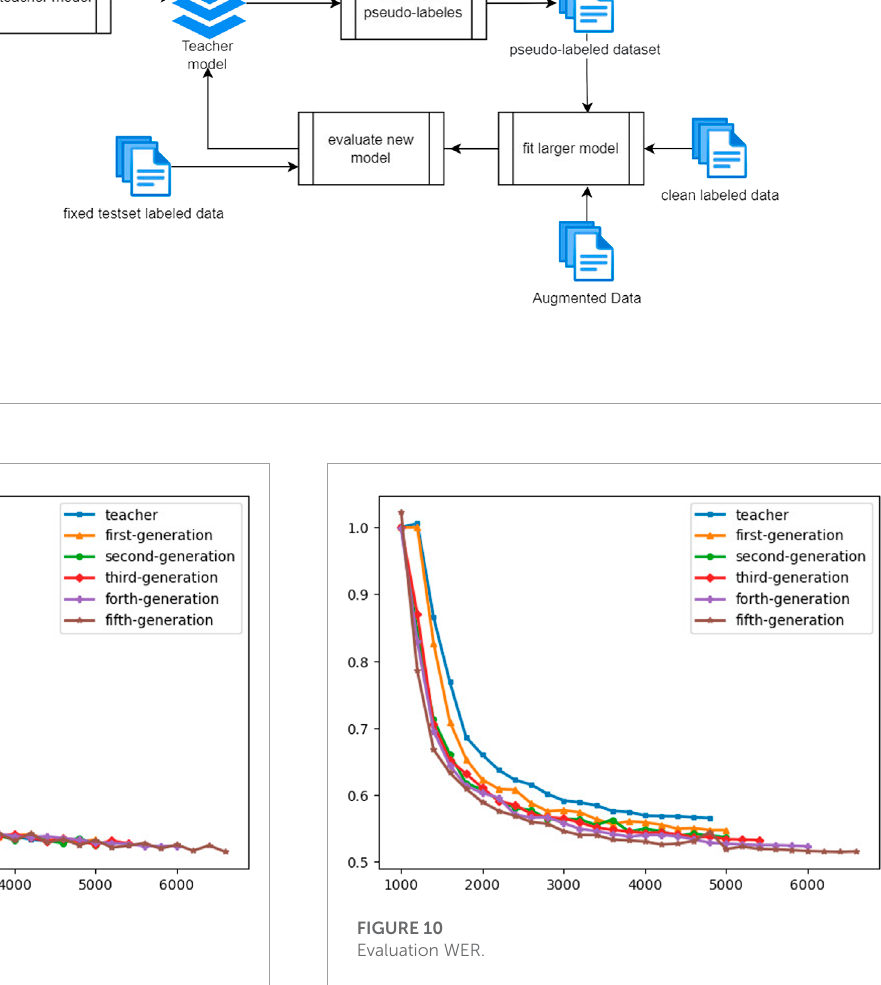
FIGURE 10 Evaluation